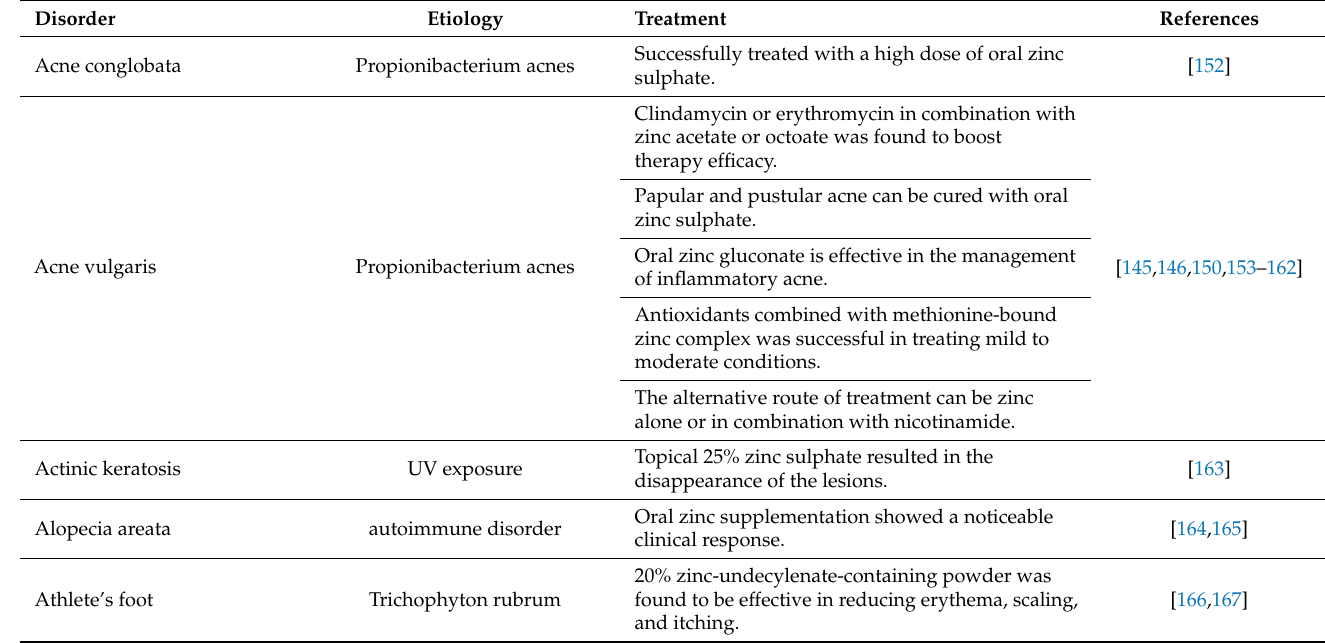
Table 1. Therapeutic applications of zinc in the treatment of various skin